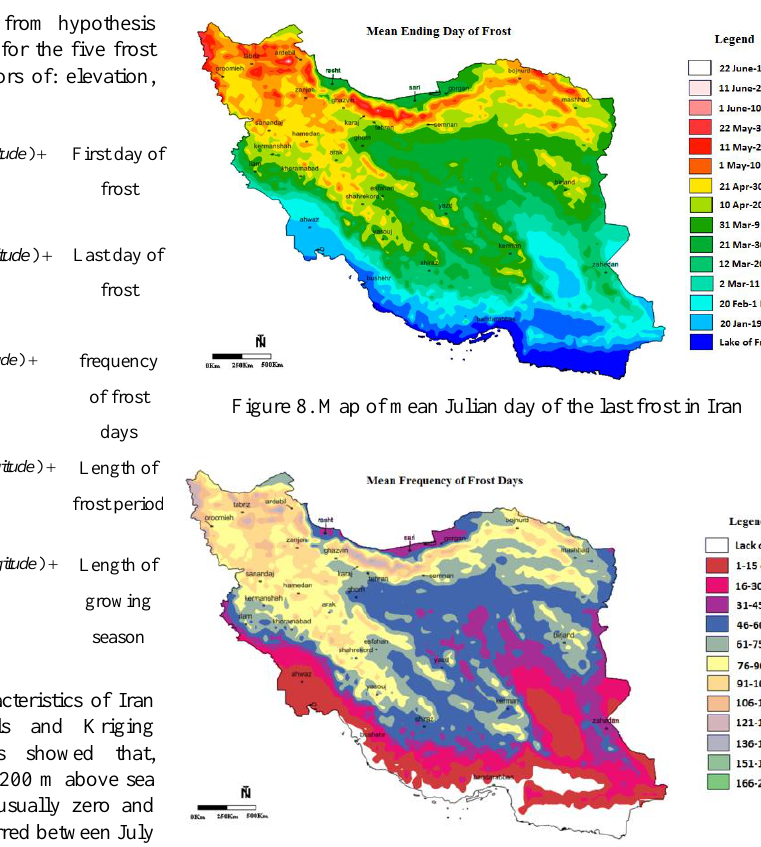
Figure 9. Map of the mean frequency of frost days